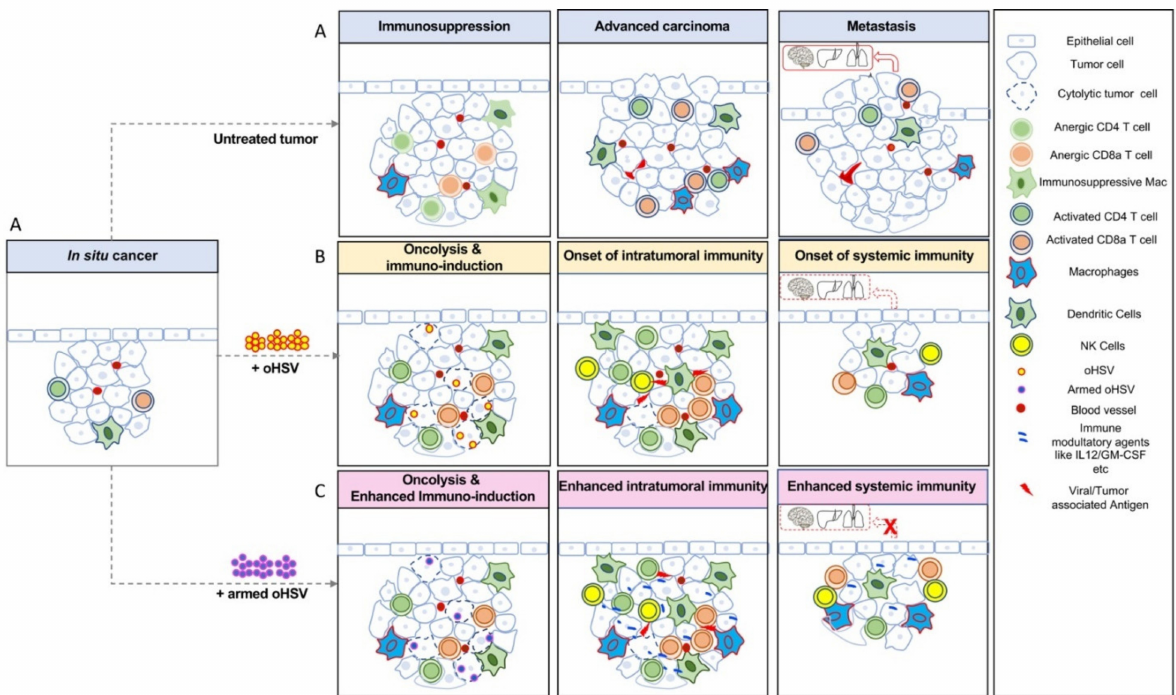
Figure 2. Oncolytic herpes simplex viruses (oHSVs) refine anti-tumor immune responses in cancer. ( A ) In situ carcinoma, localized cancer confined to the epithelial layer, where normal cells transition into cancerous cells. In untreated conditions, in situ cancer progresses to invasive cancer, where cancer cells acquire specific capabilities, transform to become invasive, and escape into the blood stream to establish new tumors in distant organs such as the lungs, brain, and liver, etc., through metastasis. ( B ) In situ cancer vaccination (ISCV) is induced by oHSV infection. oHSV induces cytolysis and cell death, as well as the release of viral antigens and tumor-associated antigens (TAAs), leading to the recruitment of innate immune cells such as NK cells and antigen-presenting cells (macrophages and DCs). Cytokines and chemokines released during